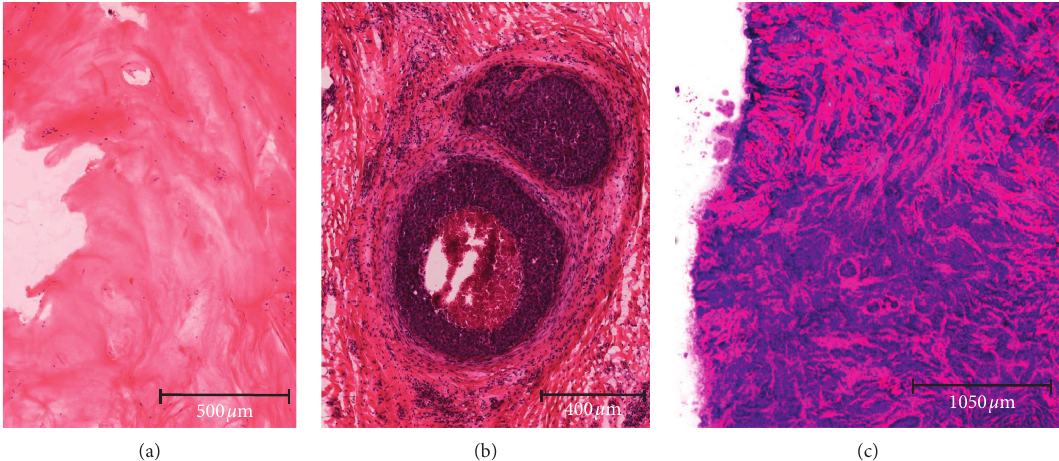
Figure 1: H&E-stained images of healthy breast tissue (a), ductal carcinoma in situ (b), and invasive ductal carcinoma (c) tissue with 500 μ m, 400 μ m, and 1050 μ m scale bar,